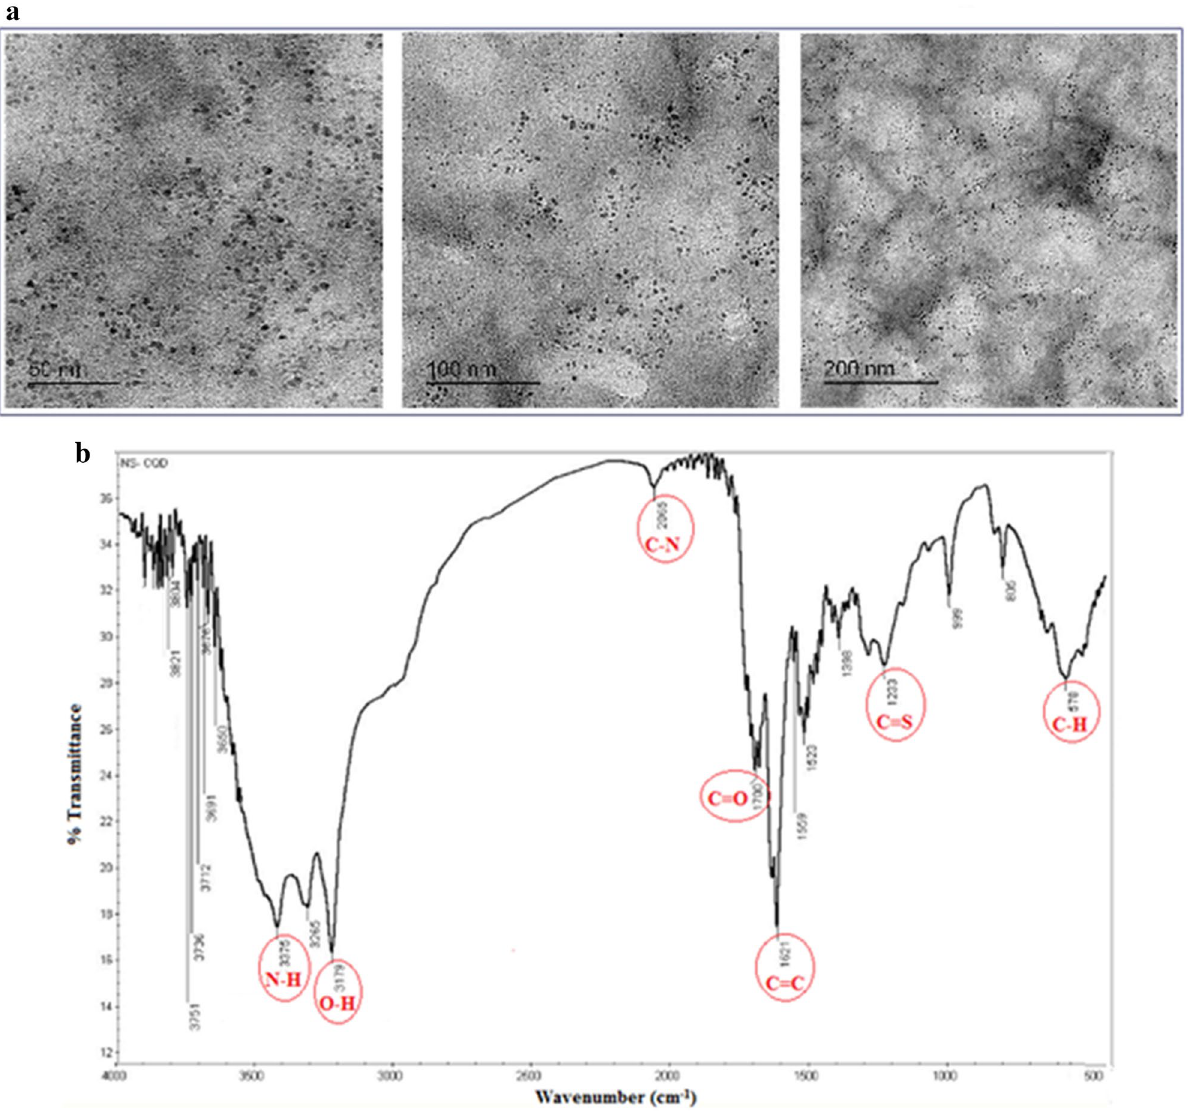
Figure 4. ( A ) The typical HRTEM images of the SN-CQDs, ( B ) FT-IR spectra of